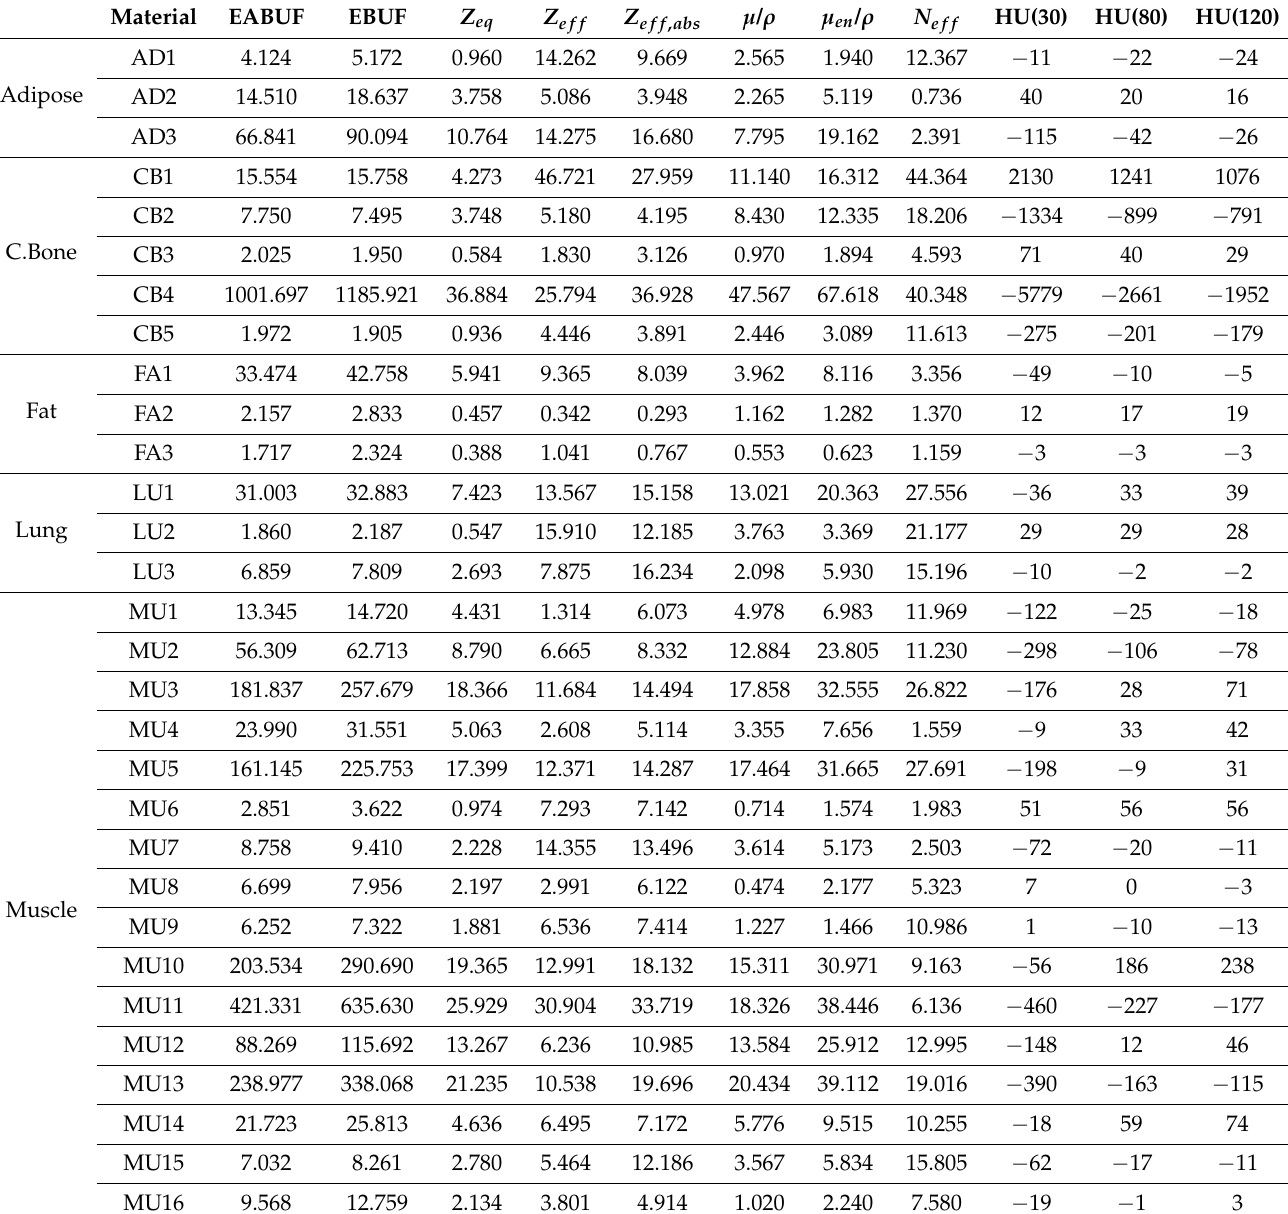
Table 4. Average relative deviation (in %) of equivalent material candidates from their reference tissues spanning both variable intervals of depth (up to 40 mfp) and photon energy (up to 150 keV). CT number differences were also given for 30, 80, and 120 kVp photon standard